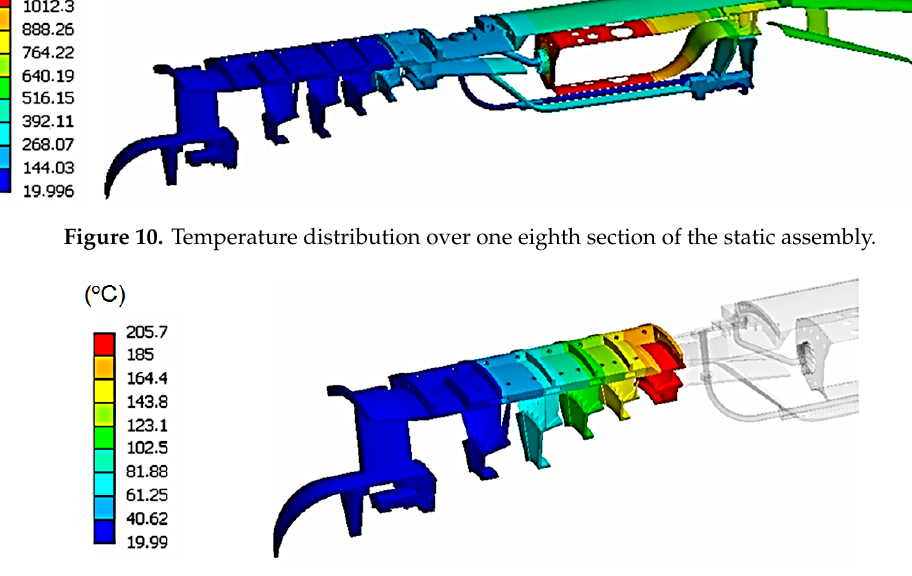
Figure 11. Temperature distribution over the compressor stator vanes.